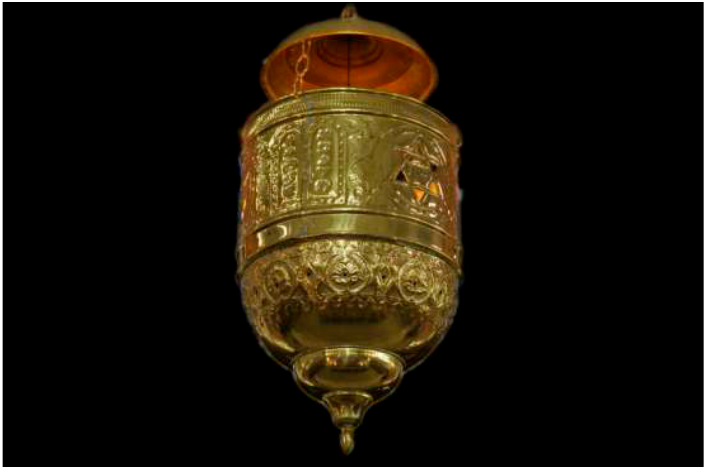
Figure 6. Chadelier at the Magen HaShalom synagogue, Ramle (photo: the author, 2006).